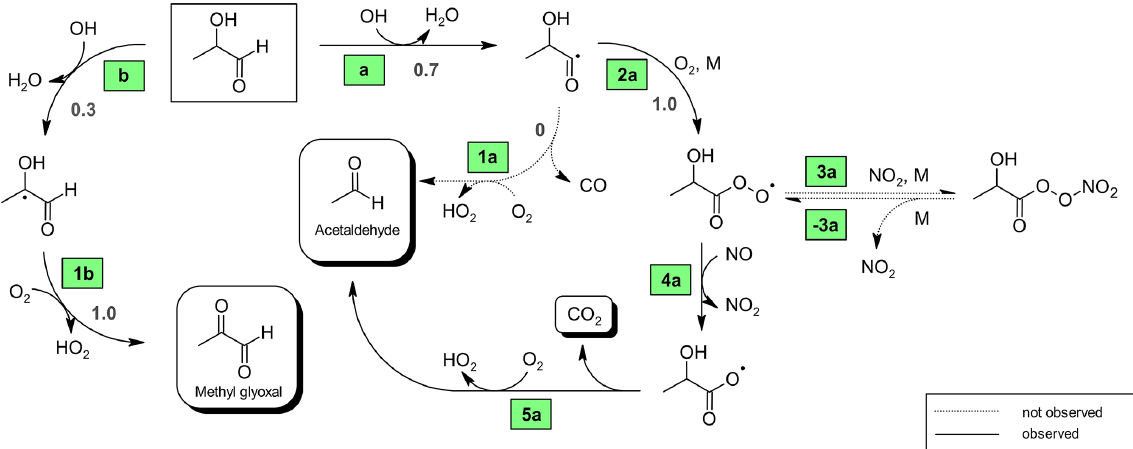
Figure 6. Proposed mechanism for the OH-radical-initiated oxidation of 2-hydroxypropanal (2HPr). Relevant branching ratios estimated within this work are denoted in grey next to the reaction